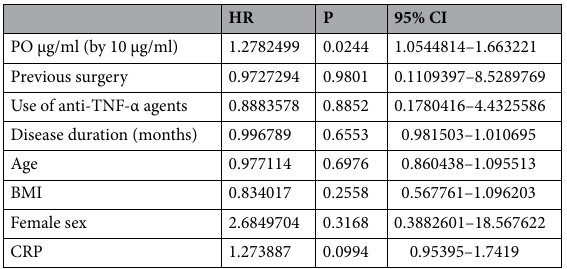
Table 2. Cox-hazard model showing the hazard risk of surgical procedures in patients with CD. CI confidence interval, PO palmitoleate acid, BMI body mass index, CRP C-reactive protein.